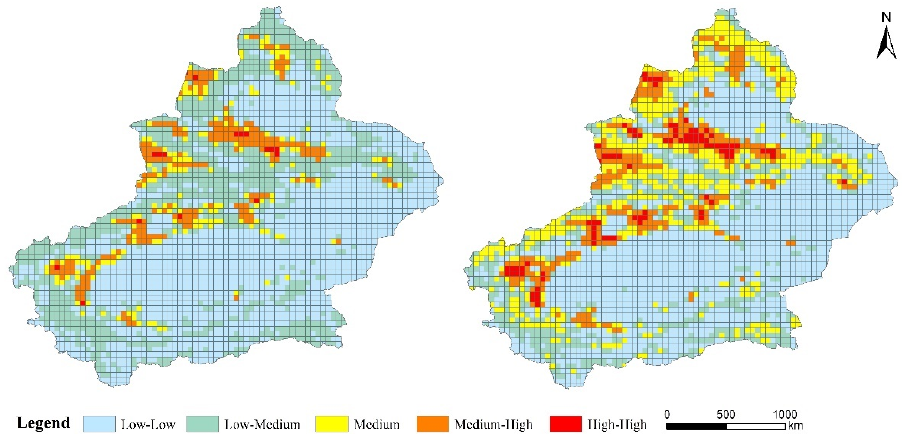
Figure 7. Distribution map of the comprehensive intensity of human interference in Xinjiang from 1990–2020.